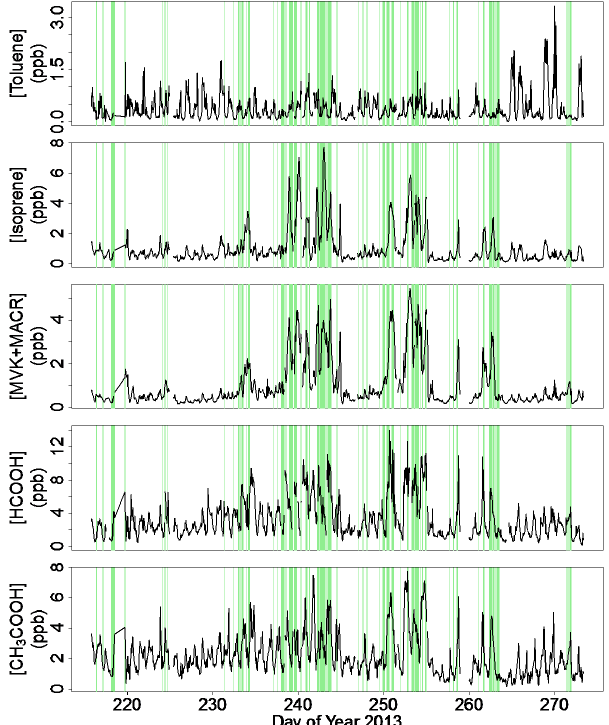
Figure 10. Timeline of chemical measurements during the SLAQRS campaign (August–September 2013) in Greater St. Louis MO–IL, USA. Green shading indicates time periods with south- westerly winds (180–270 ◦ ; wind speed > 0.5ms − 1 ) from the Ozark